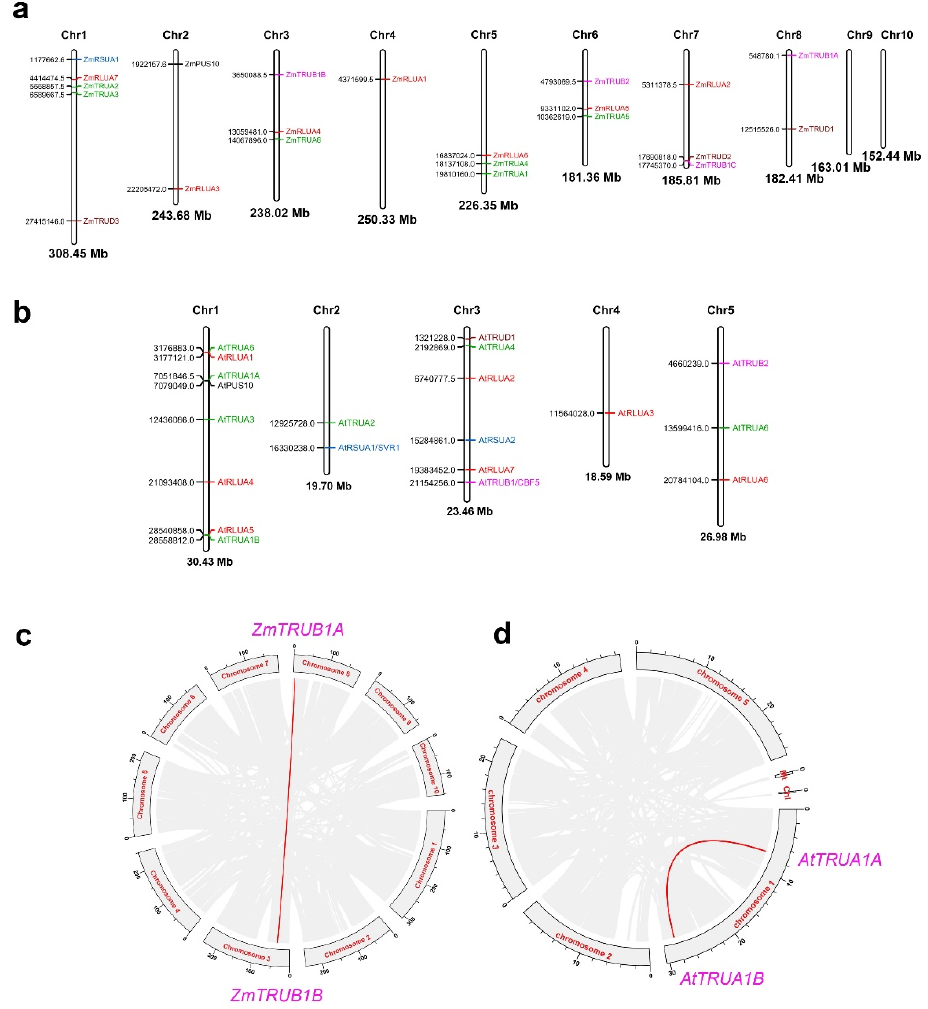
Figure 2. Chromosomal distribution and gene synteny of ZmPUS and AtPUS genes. ( a ) Chromosomal distribution of ZmPUS genes. ( b ) Chromosomal distribution of AtPUS genes. ( c ) Gene synteny of ZmPUS s in maize genome. ( d ) Gene synteny of AtPUS s in the Arabidopsis genome. The identities of the chromosome are indicated on the top of each chromosome, while the names and chromosomal coordinates of PUS s are shown to the left and the right of each chromosome, respectively. Gray lines in the background indicate the collinear blocks within the genomes of maize/ Arabidopsis , and the red lines indicate the syntenic PUS gene pairs. All chromosomes are shown to scale based on their actual lengths.